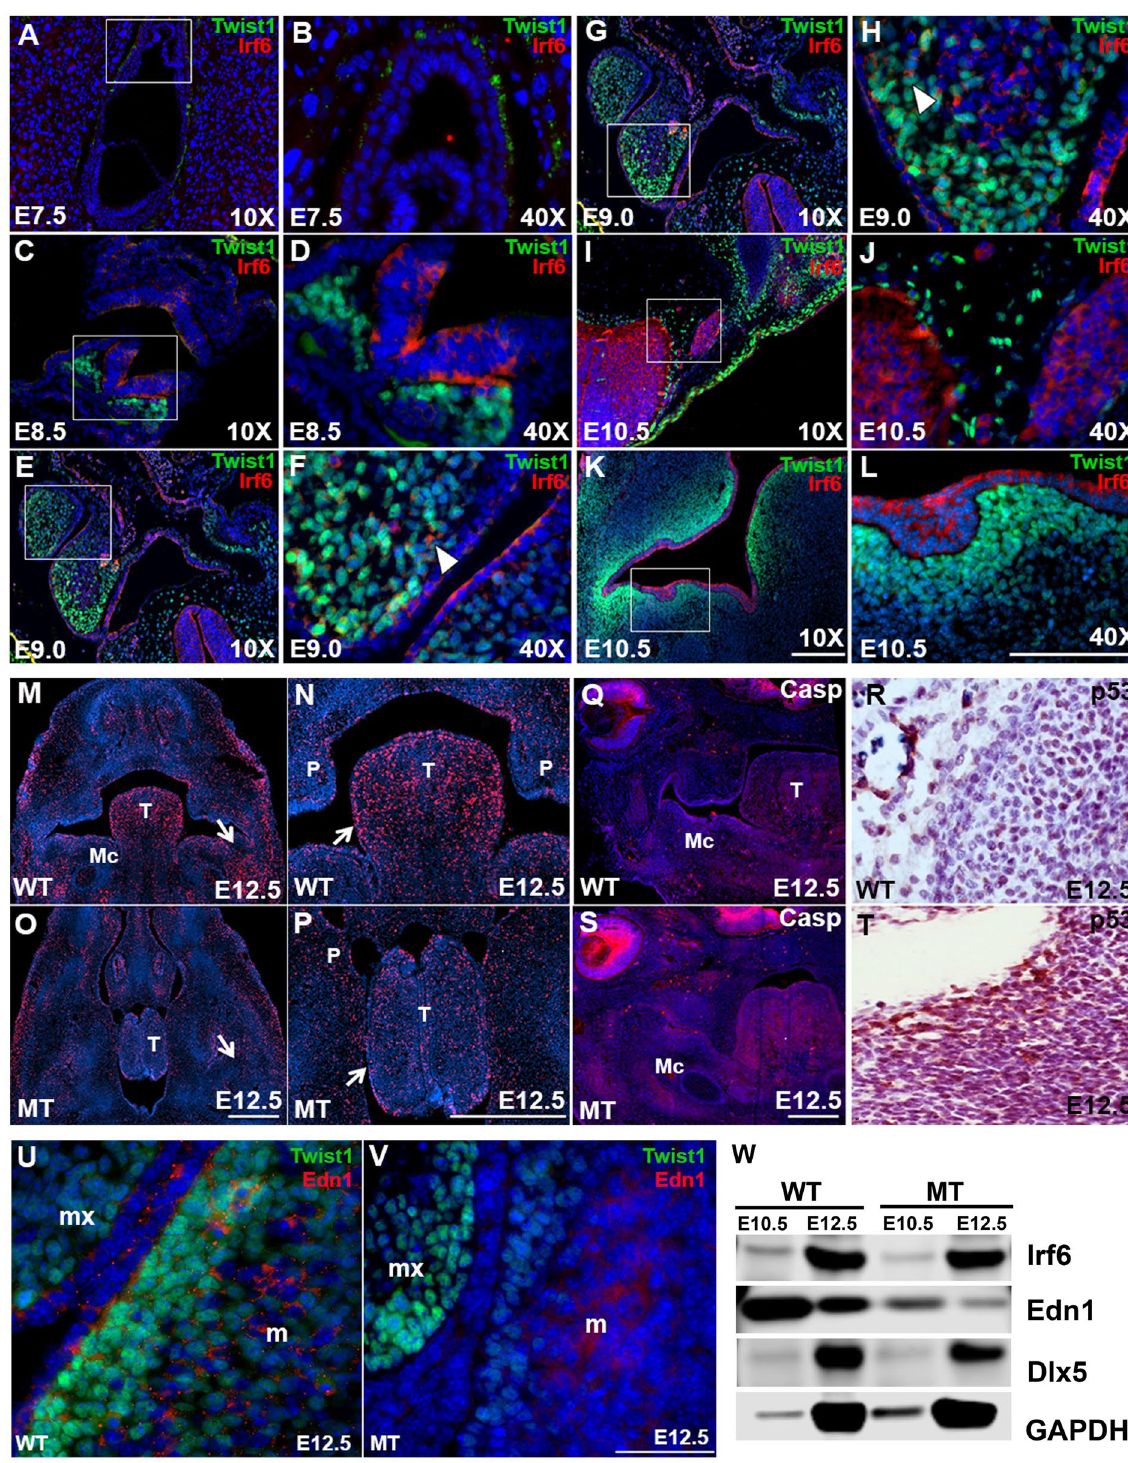
Figure 3. Immunostaining for detection of IRF6 and TWIST1 expression and immunoblot for total protein analysis. IRF6 and TWIST1 are not expressed at E7.5 ( A , B ), while their expression is detected in neuroectoderm for IRF6 and in mesoderm for TWIST1 at E8.5 ( C , D ). IRF6 expression persists in neuronal- and non-neuronal ectoderm, while TWIST1 expression is detected in CNC cells at E9.0 ( E , F ). Cytosolic IRF6 and nuclear TWIST1 are co-localized to subset of CNC cells in first and second pharyngeal arches at E9.0 (White arrowheads, F , H ). Subsequently, IRF6 is expressed in neural tube ( I , J ) and oral epithelium ( K , L ), while TWIST1 is expressed in migratory CNC cells ( I , J ) and mesenchymal cells ( K , L ) at E10.5. For assessment of cell proliferation and apoptosis, immunofluorescent images show the level of cell proliferation by highlighting the cells undergoing cell division in red in wild type embryos ( M , N ) compared to double heterozygous mutant for Irf6